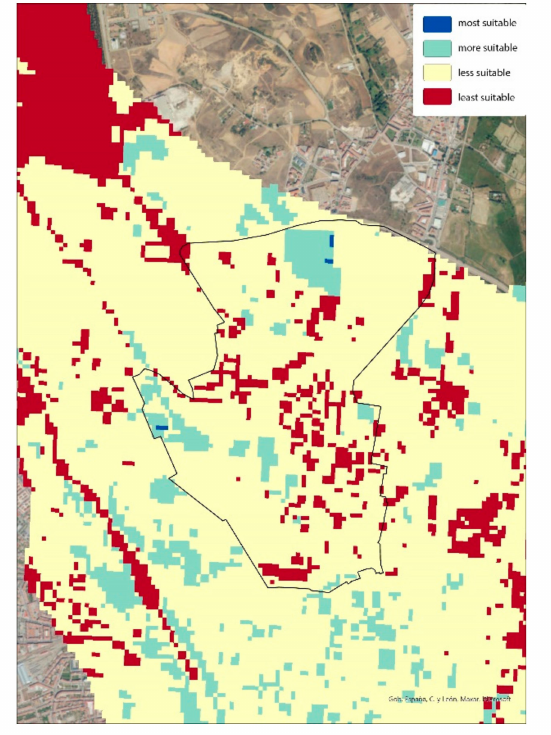
Figure A1. Leon’s preselected and candidate areas to become positive.